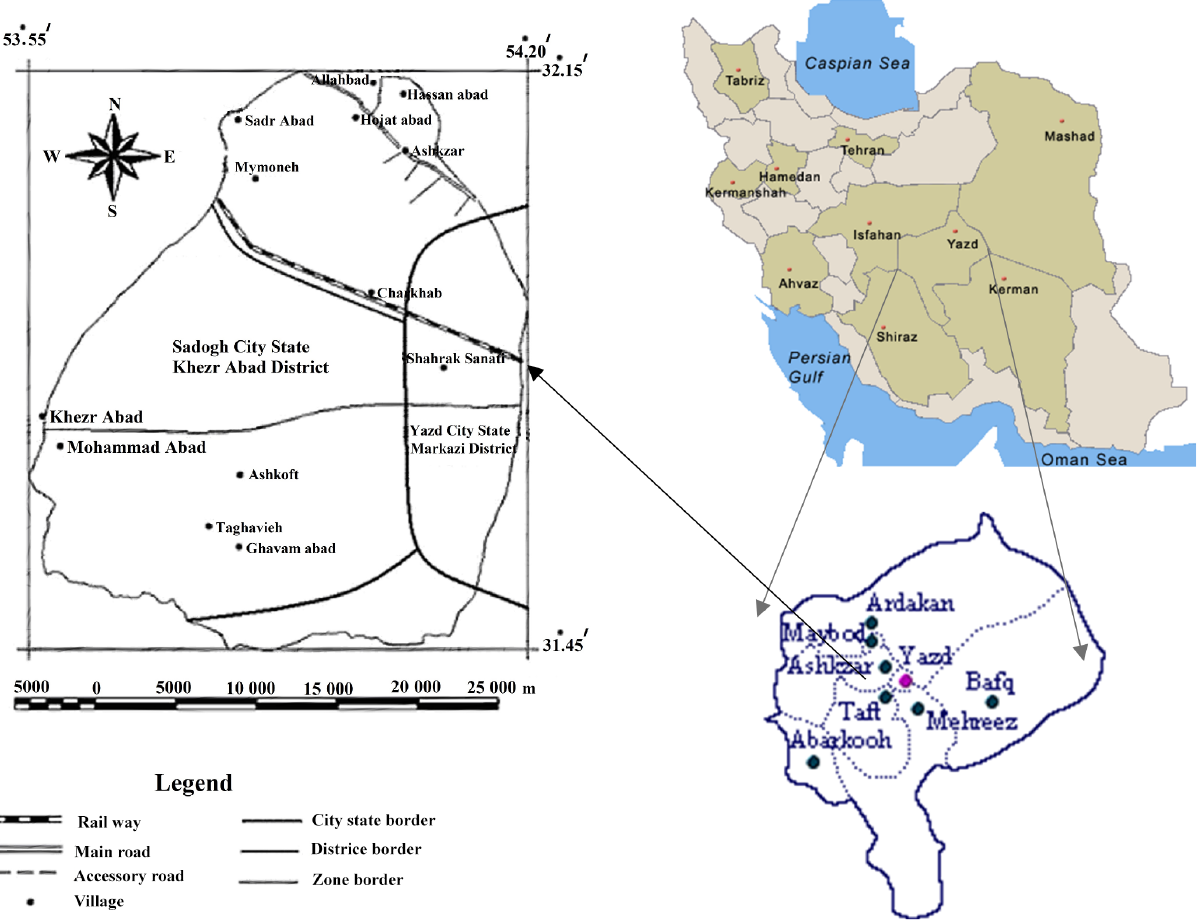
Figure 1. Location of the study